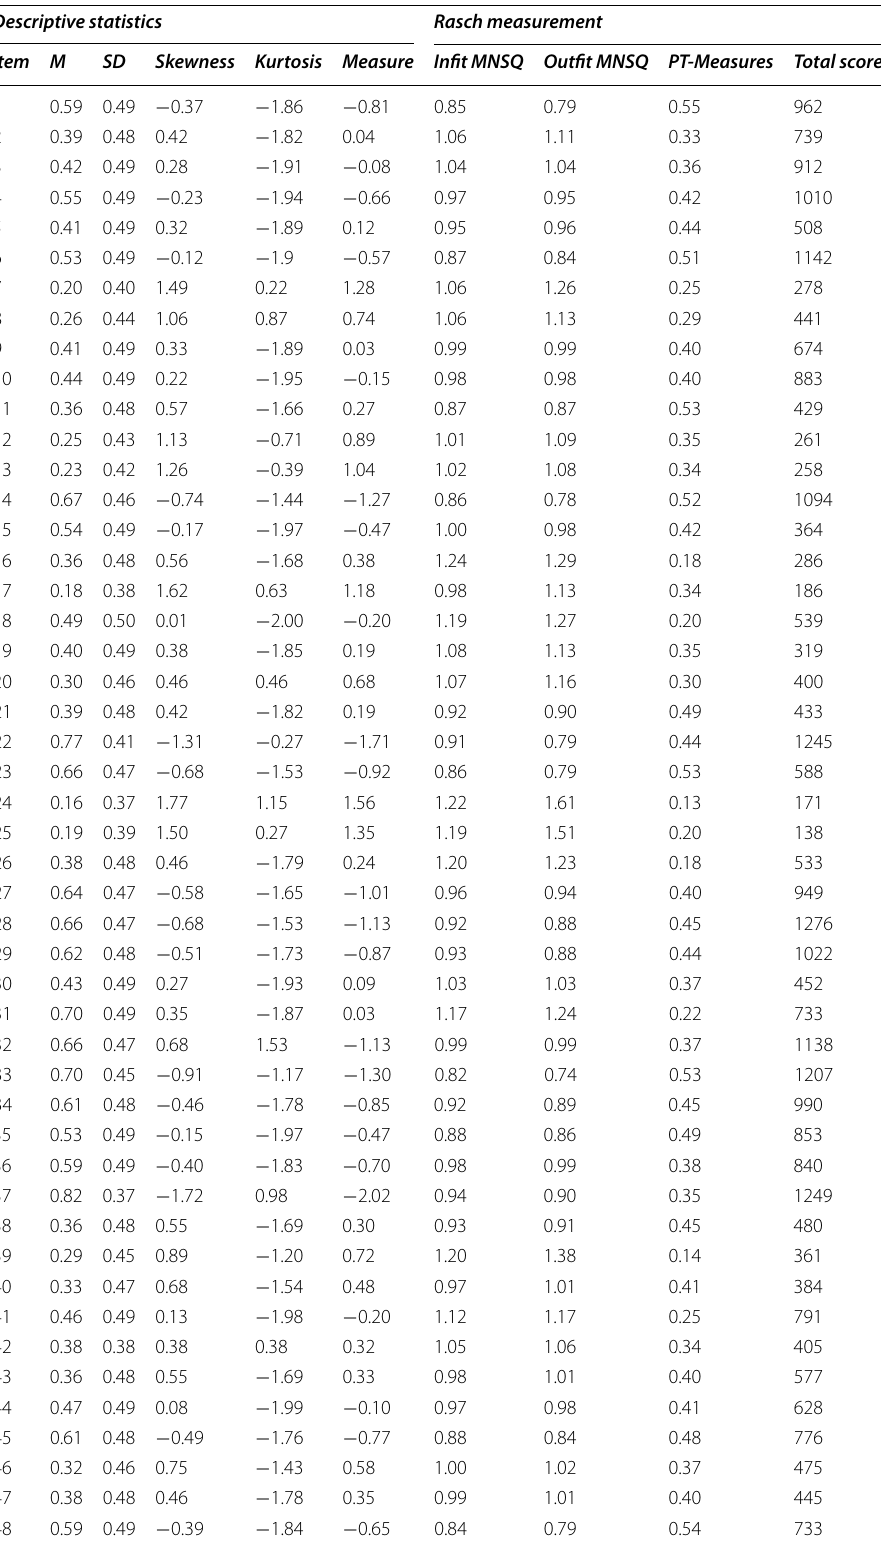
Table 18 Results of descriptive statistics analysis and Rasch measurement (IUUESEE 2017) Descriptive statistics Rasch